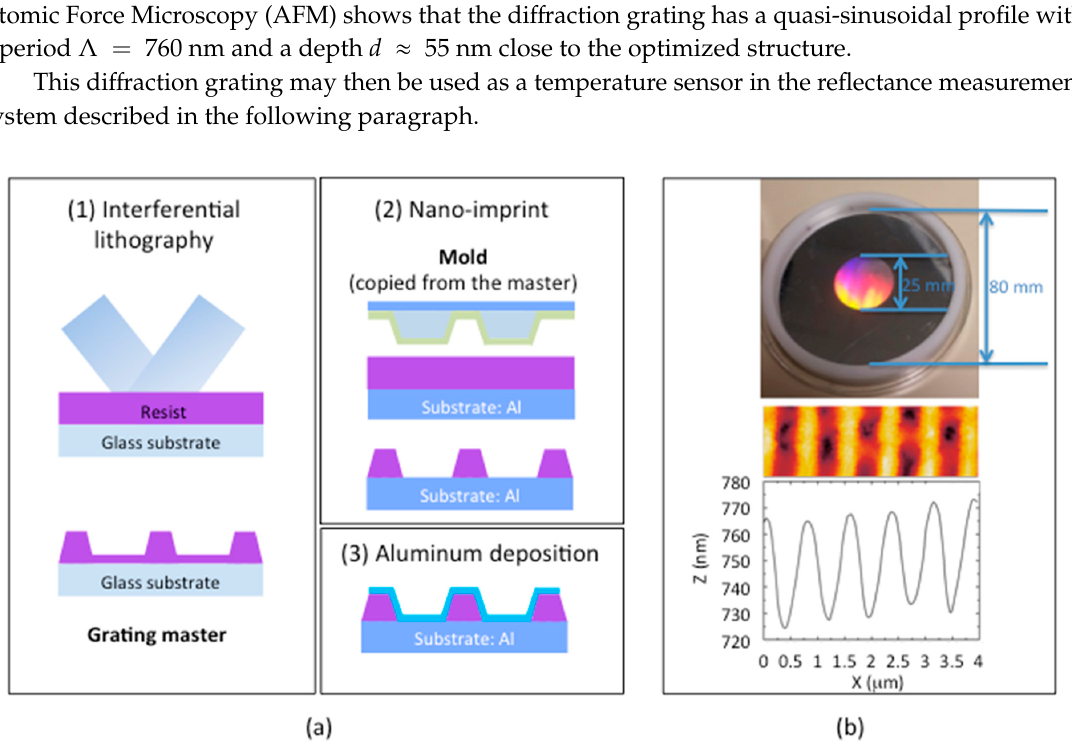
Figure 7. ( a ) Grating fabrication process steps: (1) Interferential photolithography leading to the master; (2) nano-imprint leading to the replication of the mold copied from master; (3) aluminum deposition; ( b ) diffraction grating: Photograph and AFM image.